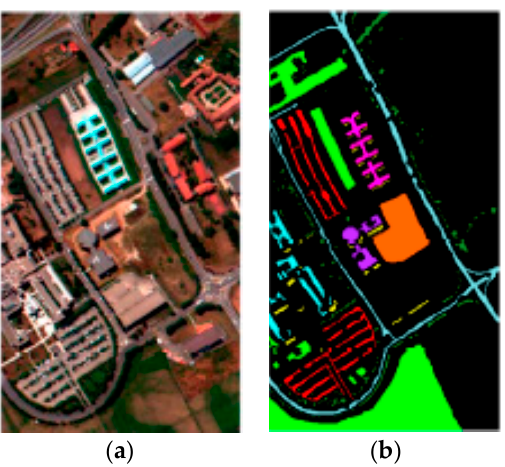
Figure 6. The Pavia University on Dataset 2. ( a ) shows the composite image; ( b ) shows the groundtruth of Pavia University dataset, white area denotes the unlabeled pixels. Table 2. Ground truth of classes and their respective sample size in the Pavia University scene.